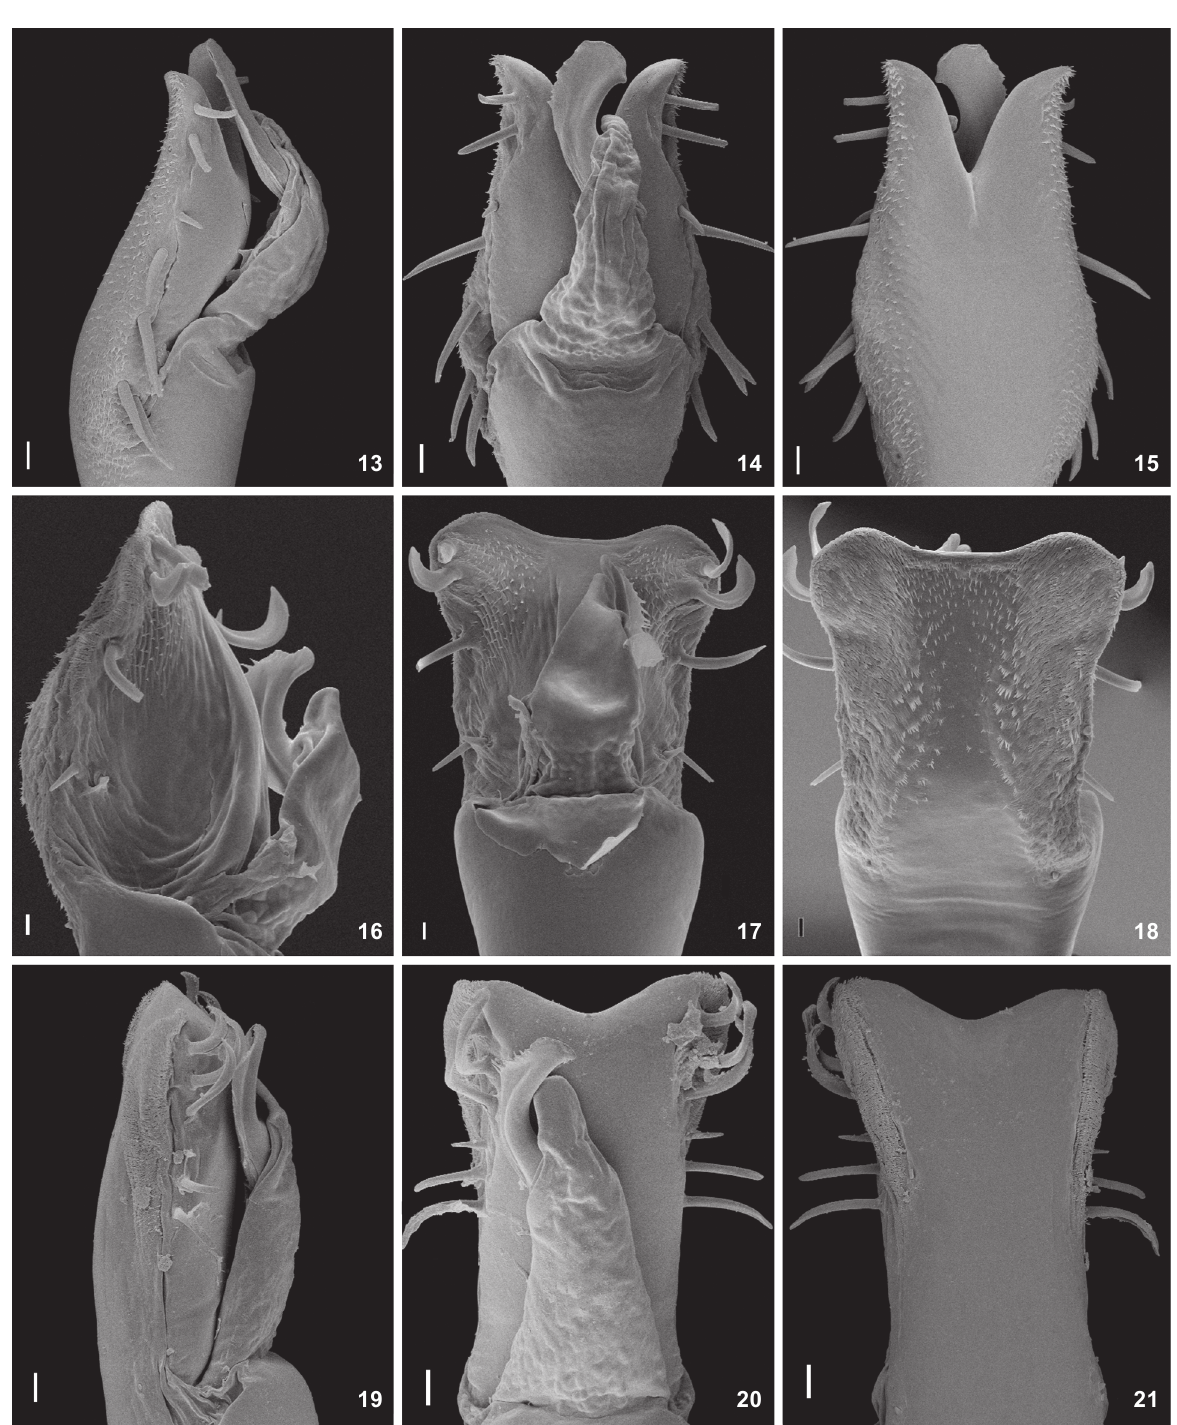
Figures 13-21. Penis of Cosmetus . (13-15) Cosmetus pollera sp. nov. (MZSP 67283): (13) Lateral view; (14) dorsal view; (15) ventral view. (16-18) Cosmetus balboa sp. nov. (MZSP OP 1565): (16) lateral view; (17) dorsal view; (18) ventral view. (19-21) Cosmetus burbayar sp. nov. (MZSP 67286): (19) lateral view; (20) dorsal view; (21) ventral view. Scale bars: (13-15; 19-21) = 20 µm: (16-18) = 10